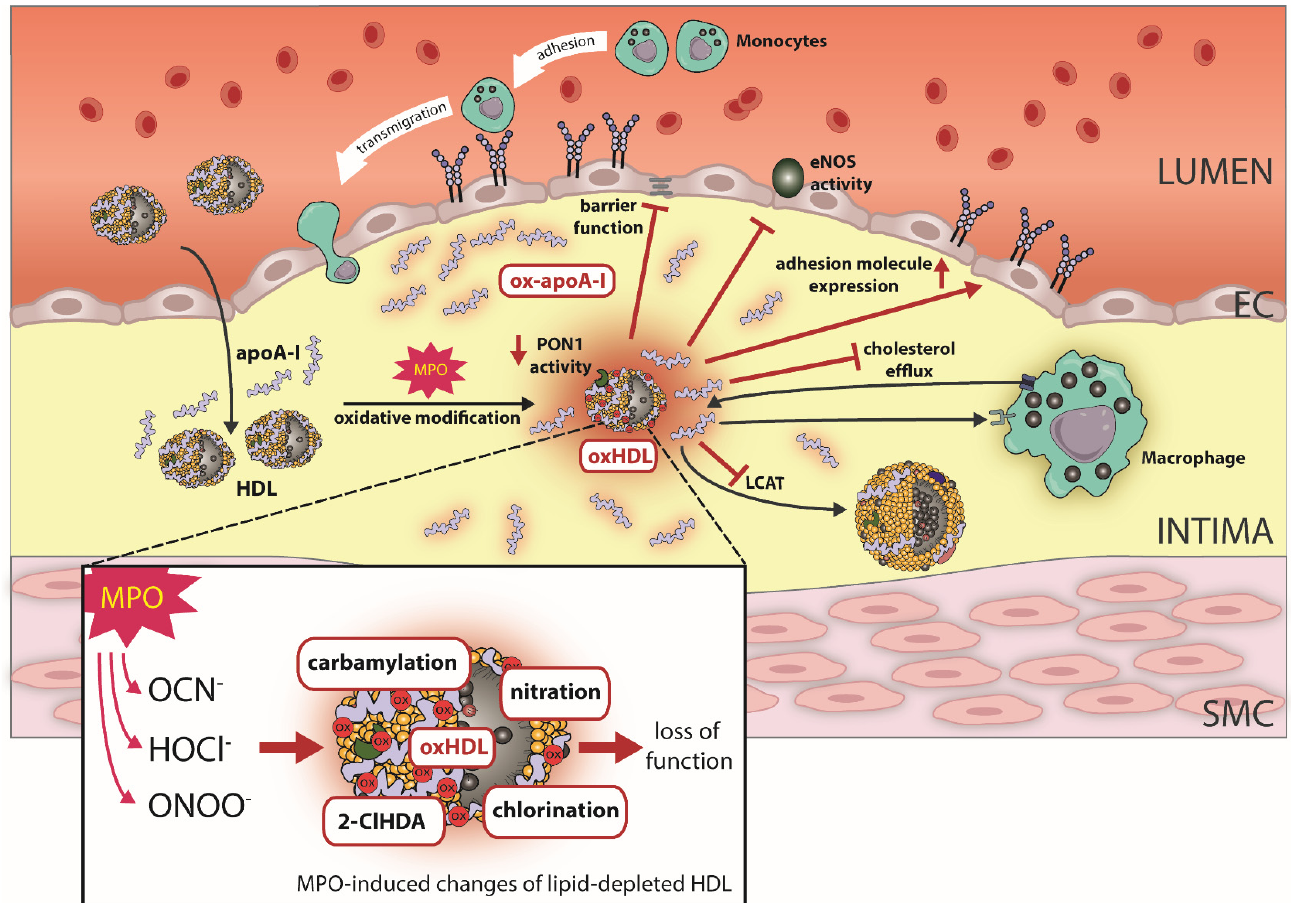
Figure 2. Effect of MPO ‐ induced oxidative modifications on HDL function. In the atherosclerotic vessel wall, HDL/apoA ‐ I is a target for MPO ‐ catalyzed oxidation. Specifically, the MPO products hypochlorus acid (HOCl − ), cyanate (OCN − ) and peroxynitrite (ONOO − ) lead to chlorination, car ‐ bamylation, nitration and the formation of the plasmalogen oxidation product 2 ‐ Chlorohexadecanal (2 ‐ ClHDA). Oxidative modifications of HDL by MPO results in loss of HDL’s ability to activate endothelial nitric oxide synthase (eNOS). Moreover, MPO modified HDL compromises endothelial barrier function and upregulates endothelial adhesion molecule expression. Further, MPO ‐ cata ‐ lyzed oxidation of HDL impairs cholesterol efflux capacity via ABCA1, whereas affinity for SR ‐ BI increases. MPO also targets PON1 and leads to decreased activity. Oxidative modifications of apoA ‐ I result in a profoundly decreased activity of LCAT. ApoA ‐ I, apolipoprotein A1; MPO, myeloperox ‐ idase; ABCA1, ATP ‐ binding cassette transporter A1.